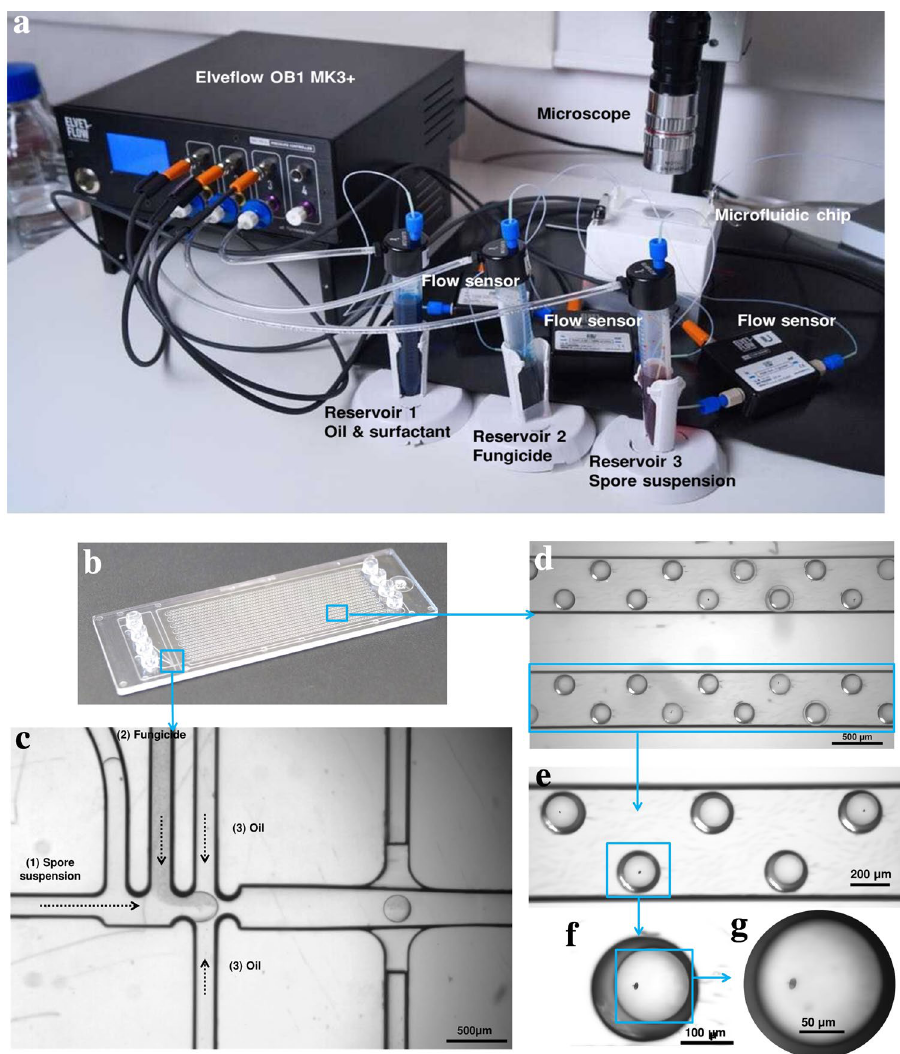
Figure 3. ( a ) An overview of the droplet-based microfluidic platform used for single spore encapsulation and antifungal analysis, ( b ) overview of PC microfluidic chip (Fluidic 719, Microfluidic ChipShop, Germany), ( c ) droplet generation process using three inlets (1) spore suspension inlet, (2) fungicide inlet and (3) oil inlet, (d-g) droplets trapped inside the storage positions from 500 to 50 µm